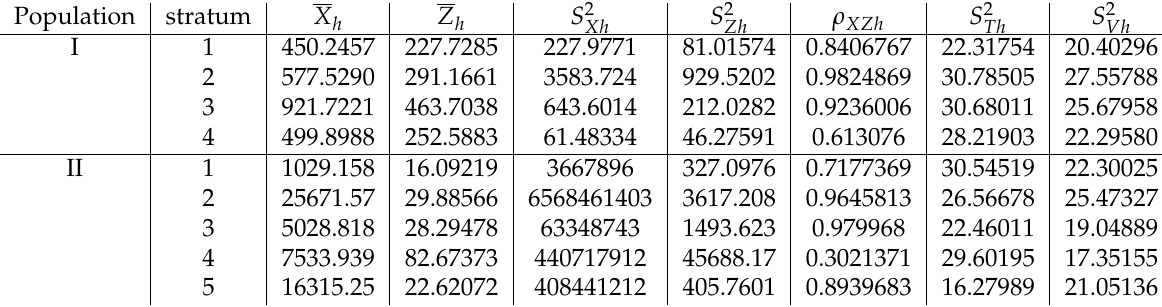
Table 1 represents summary statistics for populations I and II. Table 1. Parameters for populations I and